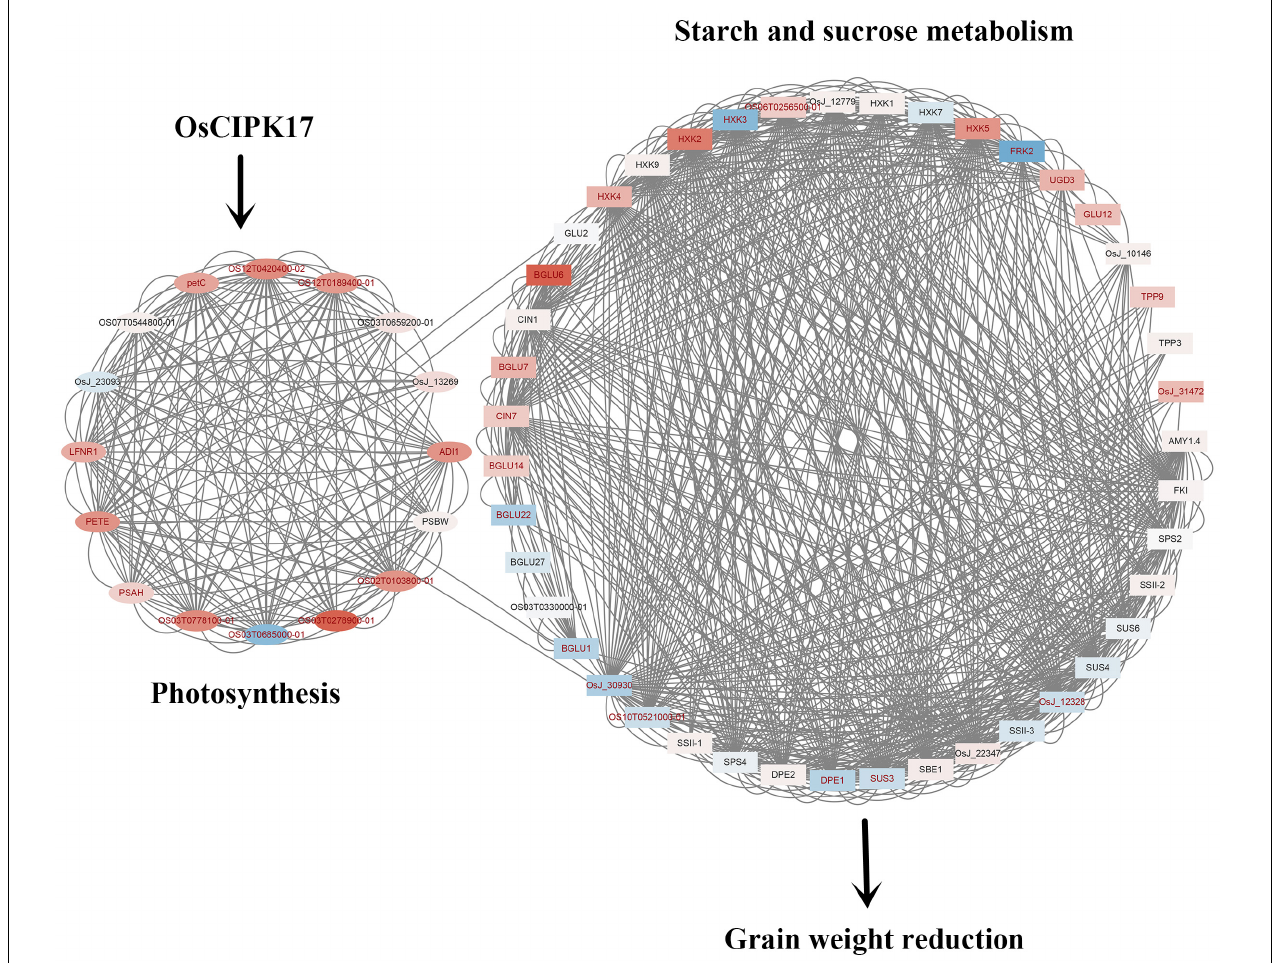
FIGURE 8 | Mechanism diagram of OsCIPK17 affecting rice grain weight. OsCIPK17 can affect photosynthesis indirectly or directly. The deficiency of photosynthesis results in impaired metabolism of starch and sucrose, resulting in decreased grain weight. The up-regulated genes and down-regulated genes were mapped with different colors. The deeper the red, the higher the expression; the darker the blue, the smaller the expression. The names of genes with significant differences in expression are indicated in red. The proteins linked by lines were predicted to have